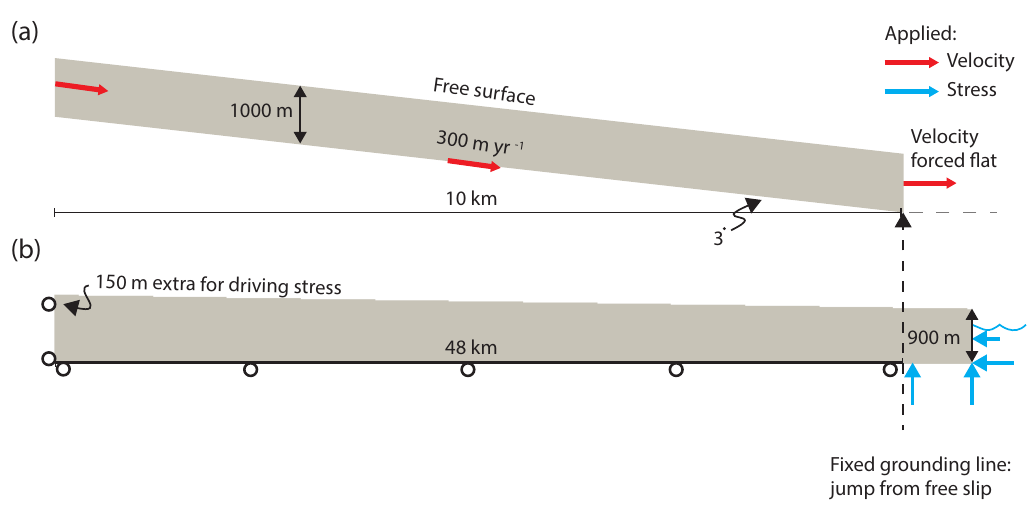
Figure 2. Schematic of experiments. (a) Experiments performed with a purely ductile or brittle rheology are initialized as a parallel-sided slab that is advected down a plane and forced flat at 10km. (b) Setup for semi-brittle rheology: a horizontal domain of 50km and a fixed grounding line at 48km, with an initial 2km of floating tongue. The left-hand side horizontal velocity is fixed at 0, and the bottom side upstream (left) of the grounding line vertical velocity is fixed at 0 (this type of boundary condition is represented schematically by open black circles). Hydrostatic and tidal stress is applied to the bottom and right-hand side of the domain downstream (right) of the grounding